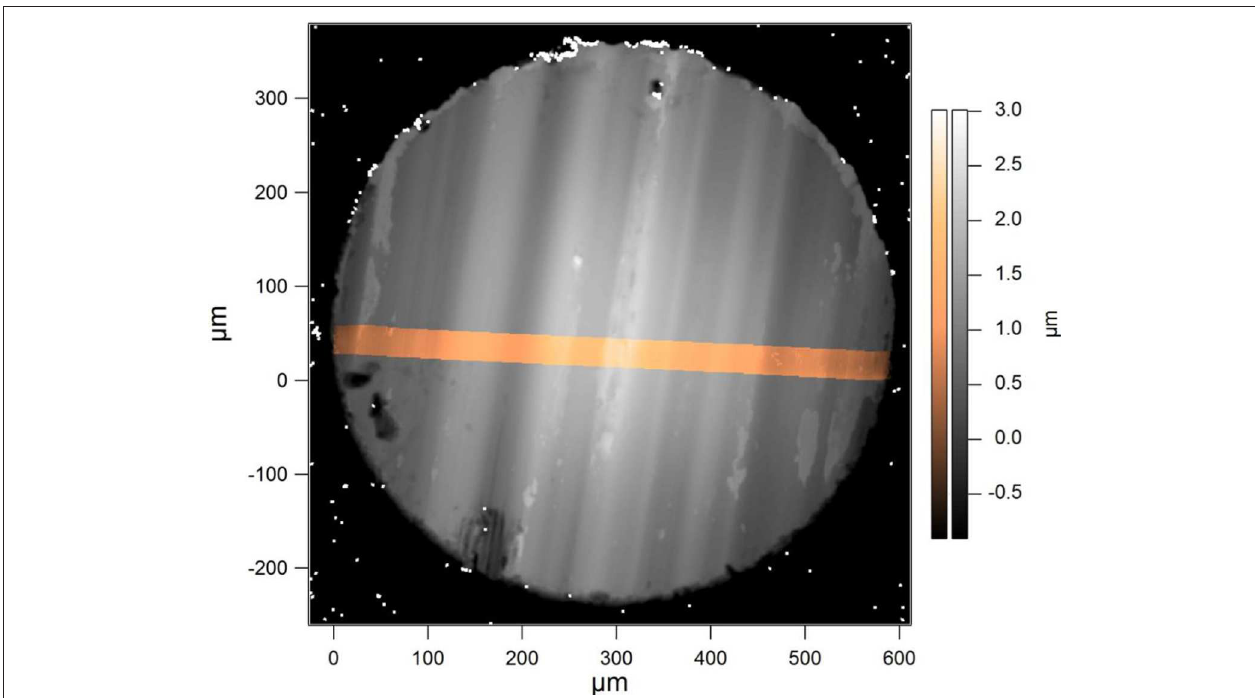
FIGURE 7 | Superposition of two topographic images of a sphere wear calotte ( R = 2mm): total image in gray color scale acquired with a white light interferometer, section in copper color scale stitched from 26 AFM contact